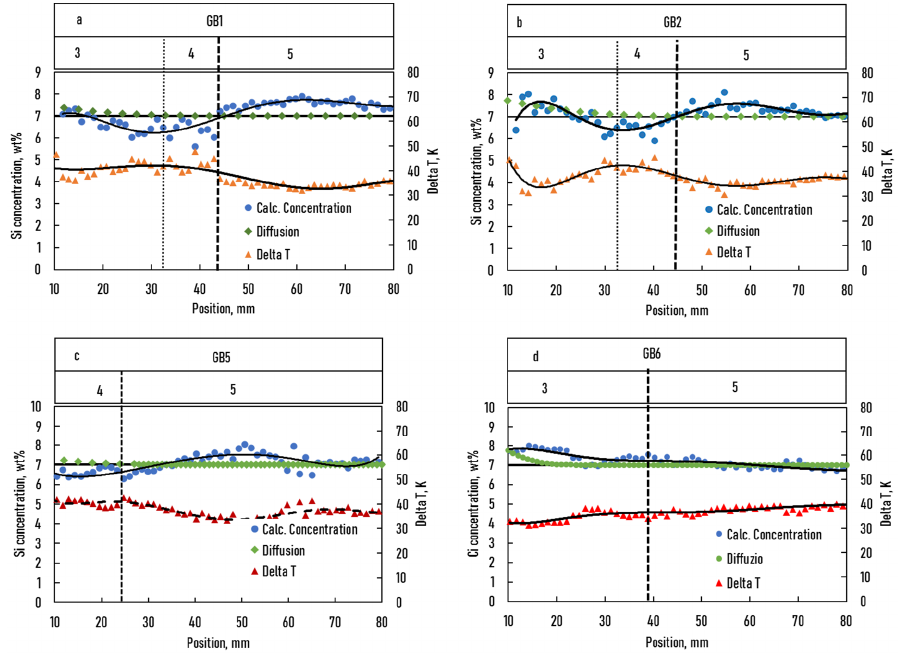
Figure 13. Calculated Si concentration from the corrected measured amount of eutectic and the calculated temperature range of solidification ( Delta T = TL − TE) vs. position in the samples.